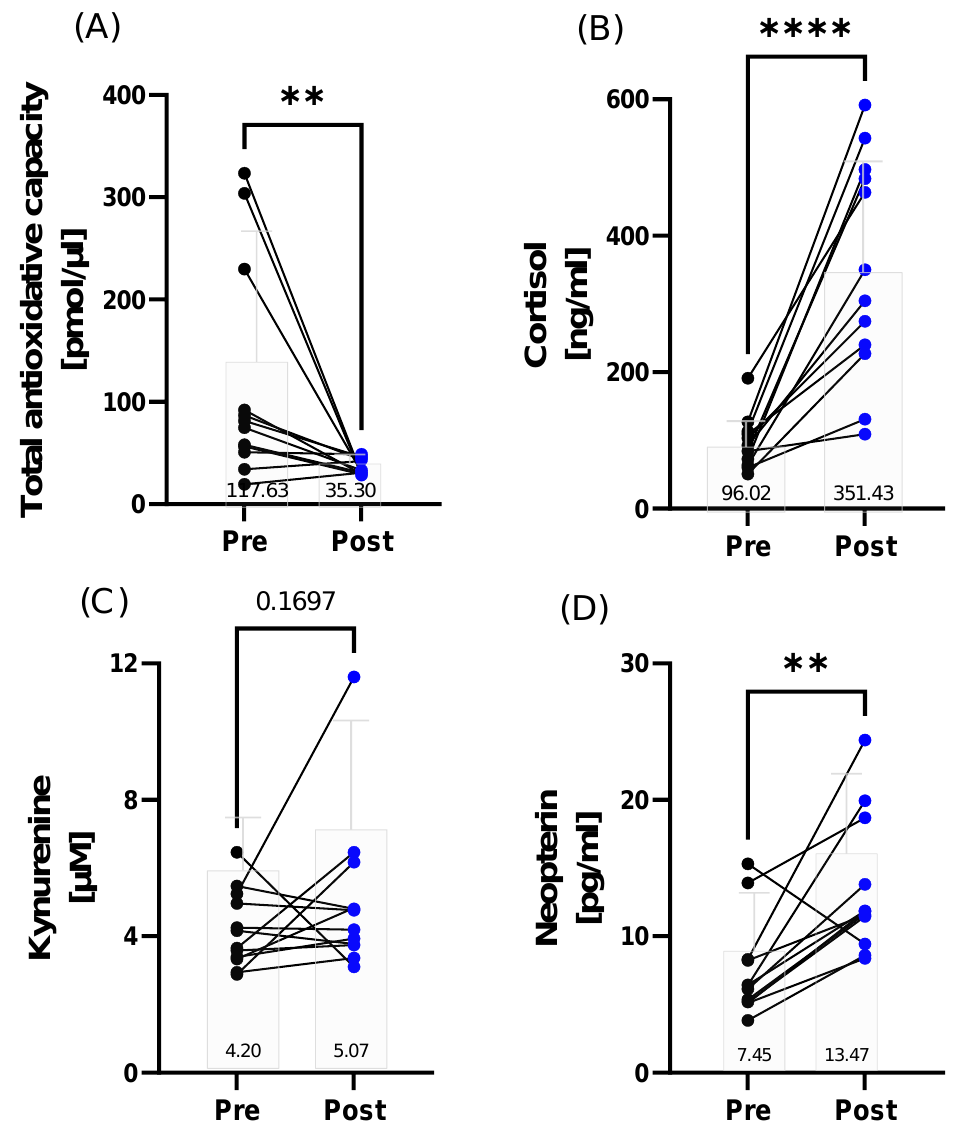
Figure 3. Stress response and immunological variables in the 160.9/230 km race finishers ( n = 12) before (pre) and after (post) the 160.9/230 km competition. ( A ) Total antioxidative capacity decreased post-race and ( B ) cortisol levels increased after the race. ( C ) Kynurenine concentrations remained unchanged. ( D ) Neopterin levels increased post-race. Presented are individual changes as well as mean number values. ** p ≤ 0.01; **** p ≤